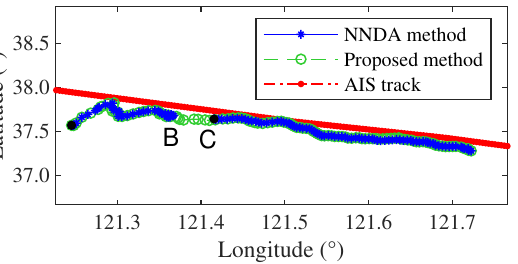
Figure 13. Tracking results comparison of T1. Point A indicates the position where the track breaks.